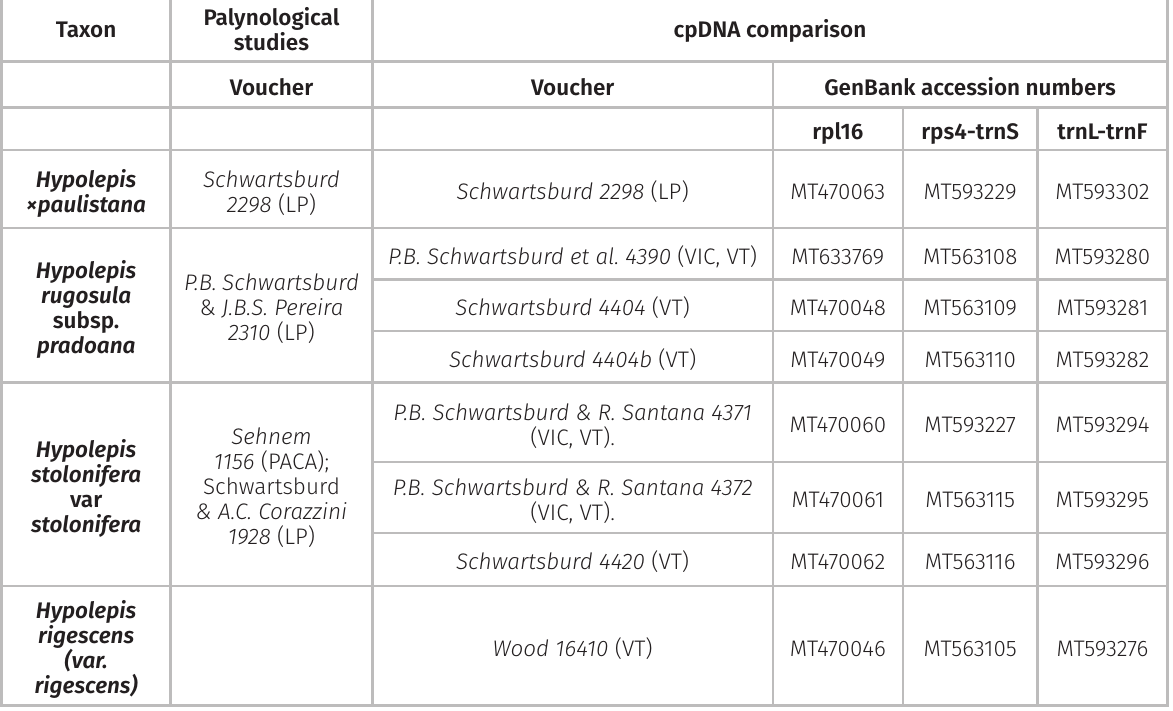
Table III. Specimens examined of Hypolepis × paulistana potential parent species. Palynological Taxon studies